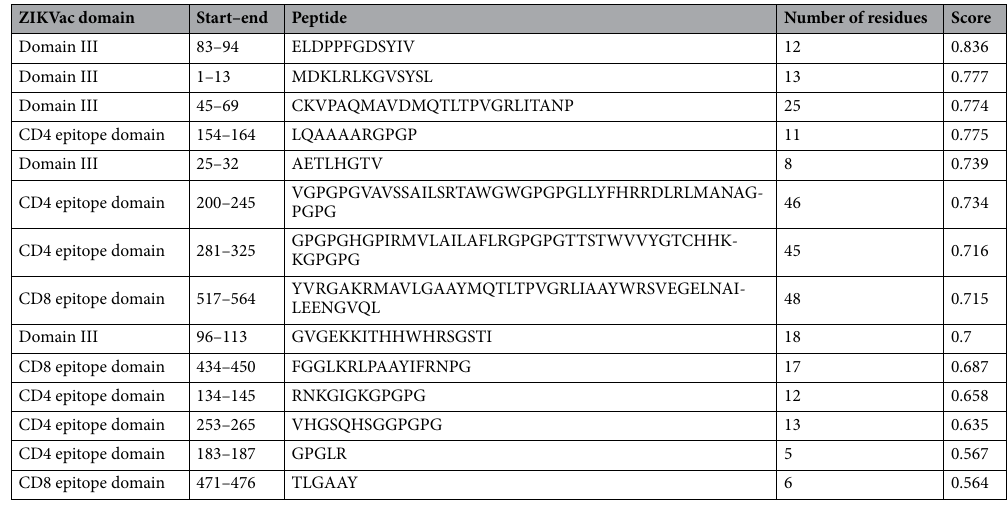
Table 4. Predicted Linear B cell Epitopes from